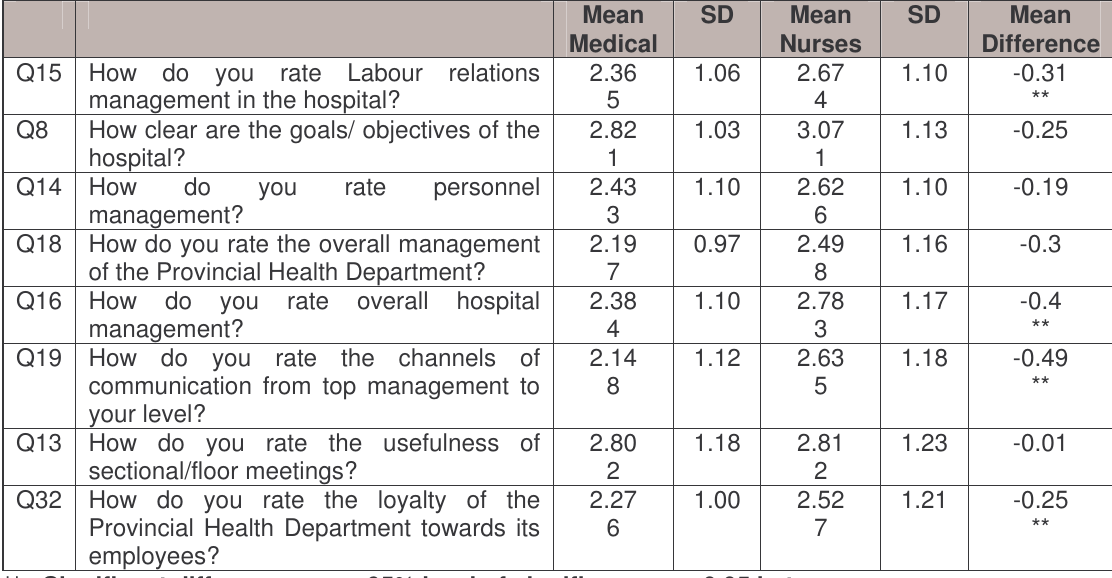
**= Significant differences on a 95% level of significance p < 0.05 between groups Rankings are indicated below the means The highest score in the management policy category (Table 2) was recorded by the nursing staff on clarity of the goals/objectives of the hospital, while the lowest score was recorded on the loyalty of the Provincial Health Department towards its employees. Medical staff members also evaluated the clarity of the goals/objectives of the hospital as being the highest while the lines of communication from top management to their level were evaluated as least satisfactory. Significant differences were measured in terms of variables 5, 16, 19 and